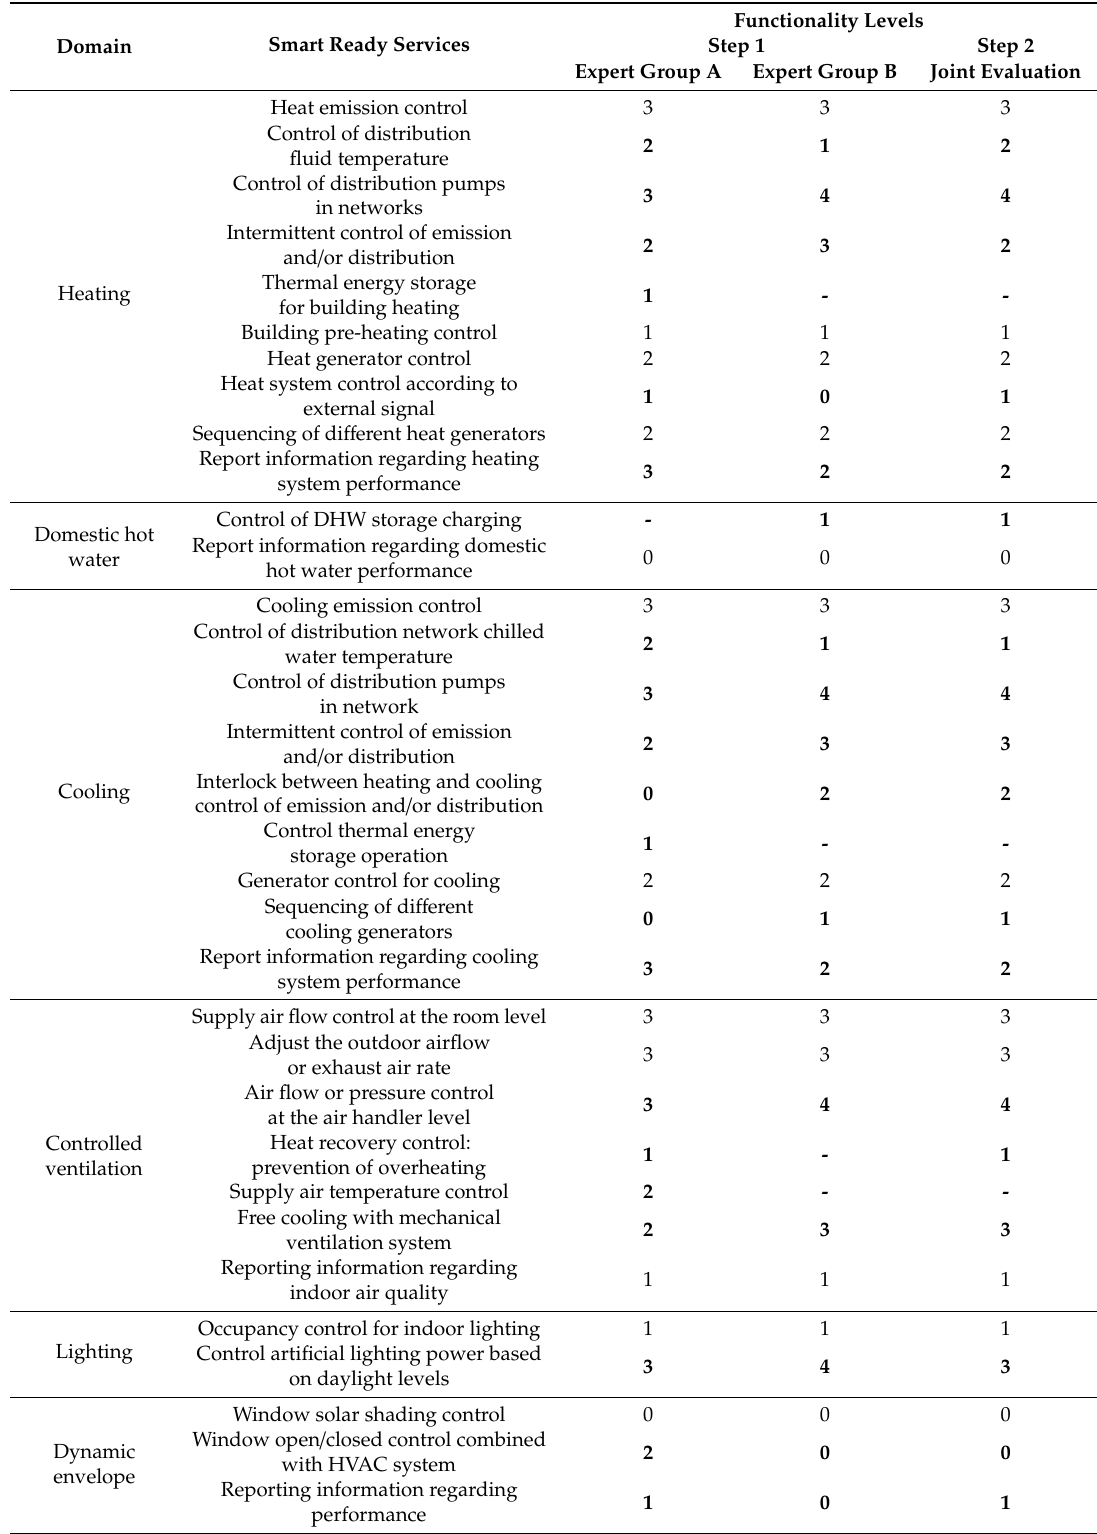
Table 4. Excel-based calculation tool. Choice of functionality levels for each smart service available in the case study building (in bold in the table when assessed di ff